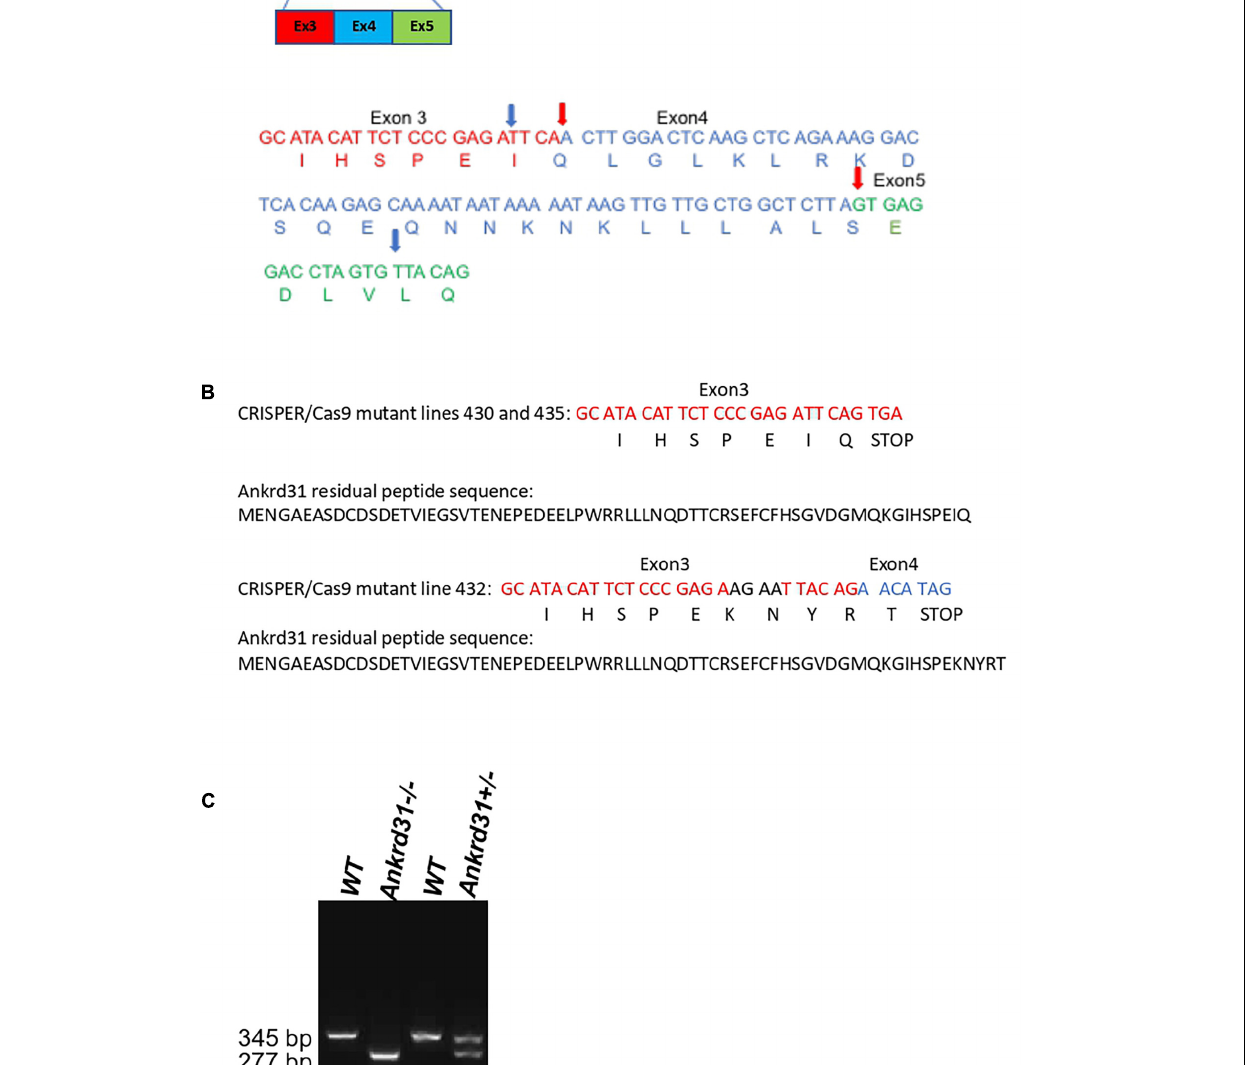
Ankrd31 gene deletion negatively affected only male reproductive abilities. Sperm parameters were assessed from sperm cells collected from WT and Ankrd31 − / − cauda epididymides. Sperm cell number was significantly lower in Ankrd31 − / − as suggested by FACS analysis ( Figure 4A ).